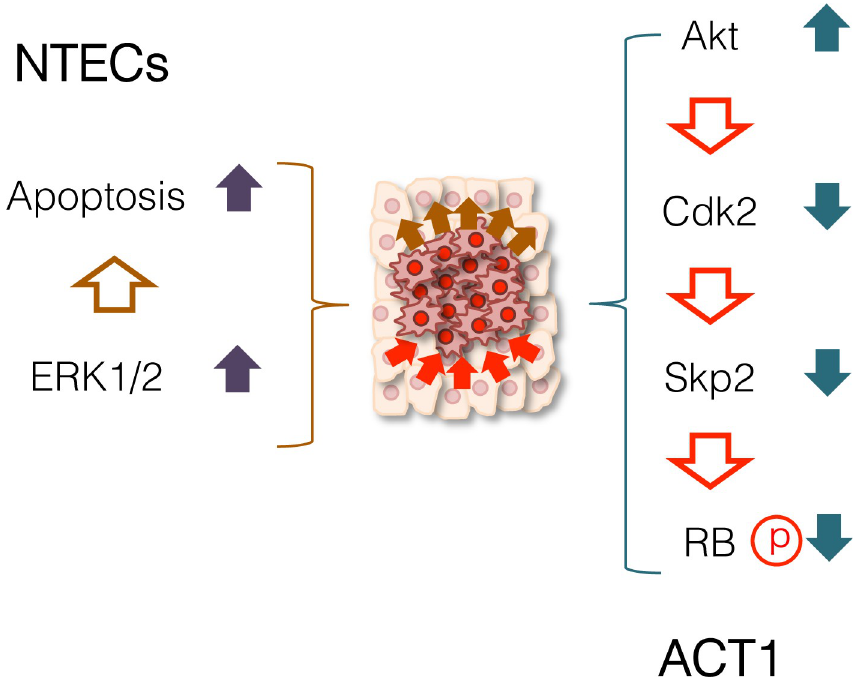
Fig 11. Summary of reciprocal stress response. Cell competition between anaplastic thyroid cancer cells and normal thyroid follicular epithelial cells provoked reciprocal stress response. In competed ACT1 cell clusters, activation of Akt resulted in dephosphorylation of RB, which gave rise to reduced growth. In contrast, competed NTECs, especially those neighboring ACT1 clusters, were forced to die by apoptosis via unscheduled activation of ERK1/2. Our results demonstrate that cell competition is a bi-directional phenomenon, thourgh which the initiation, propagation, and metastasis of tumors are hindered.